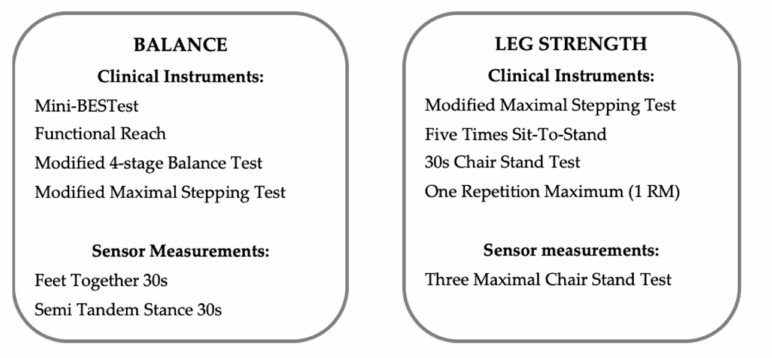
Figure 1. Clinical tests for balance and functional leg strength as well as sensor measurements with the MyBalance prototype used in this